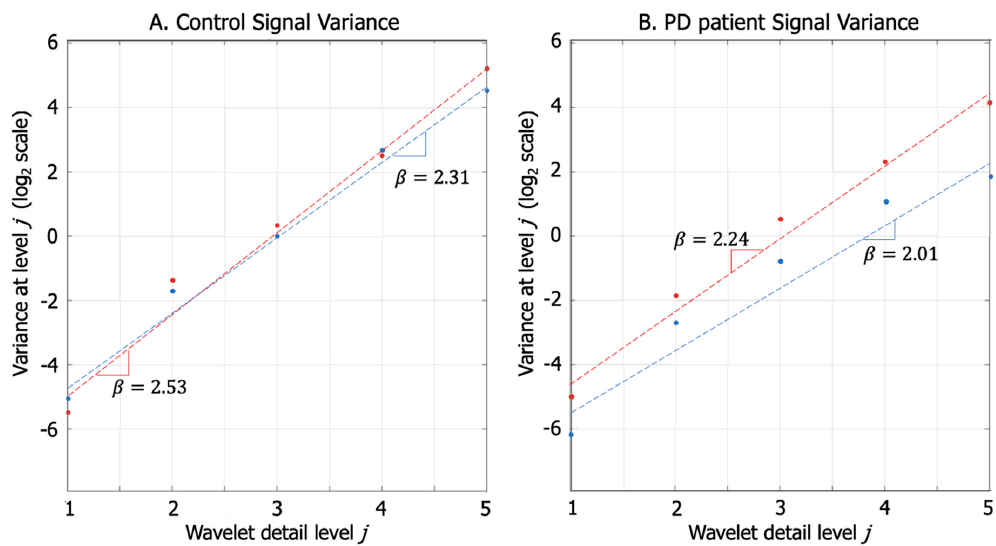
Figure 6. Variance at the wavelet level of detail j (in log 2 scale) for an PD patient and a control. (Red indicates the left arm, and blue indicates the right arm). ( A ) Control signal variance. Both arms variance through wavelet decomposition present linear trend, which causes a slightly different slope in the line ( β ). ( B ) PD patient signal variance. The less affected arm has a normal slope ( β ), but the affected arm presents a lower slope ( β = 2.01).